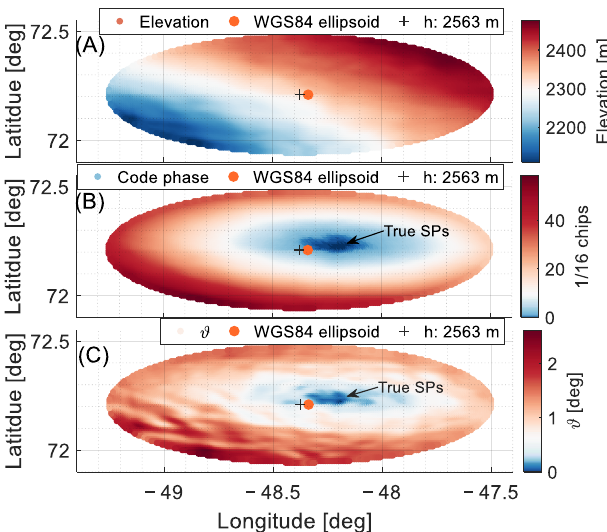
Figure 3. Analysis of the specular point over the slope. The topography data is extracted from RTopo-2 [51] and centered to the specular point at the WGS84 ellipsoid surface, with a radius of 20km. Above panel ( A ) presents the local topography with a slope of 0.43%. The middle panel ( B ) shows the relative TPL (normalized to the chip length of the C/A code). The probability of contributing to the receiver represented by ϑ is shown in ( C ). Black cross and brick red dots in each plot are the results calculated by specular point algorithms without and with considering the mean surface height of the local area, respectively.